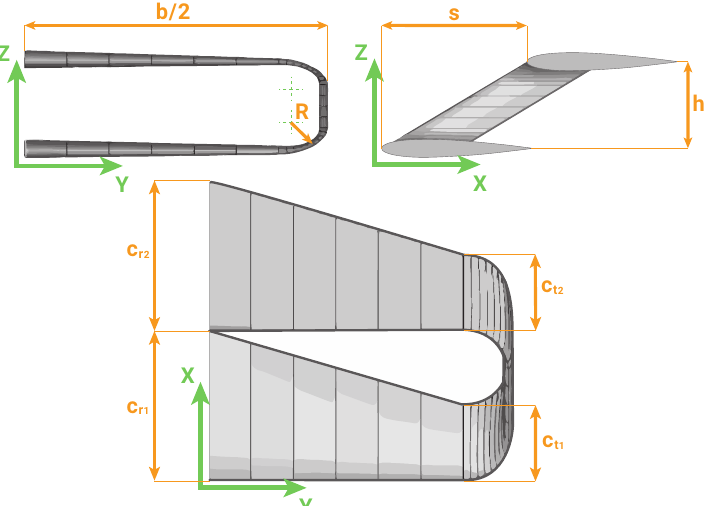
Figure 3. Box wing parameters (adapted from [20]). Note that positive stagger means a downstream positioned upper wing, which is the opposite of the standard